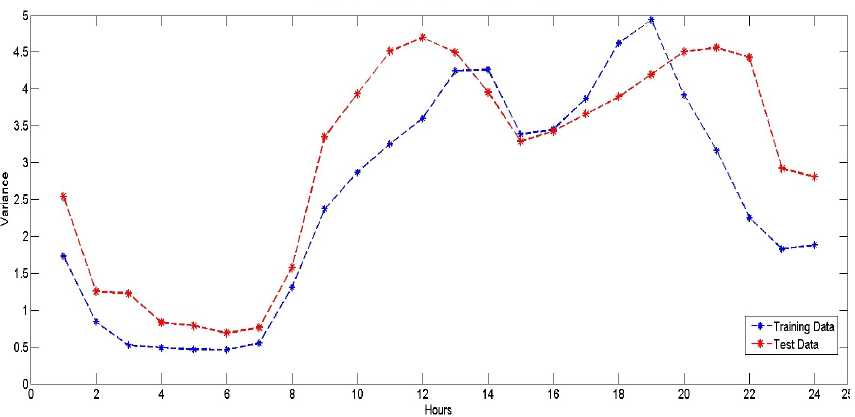
Figure 6. Hourly variance in training and testing data for OMEL